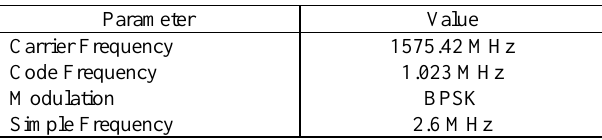
Table 1. the parameters of Signal Simulator